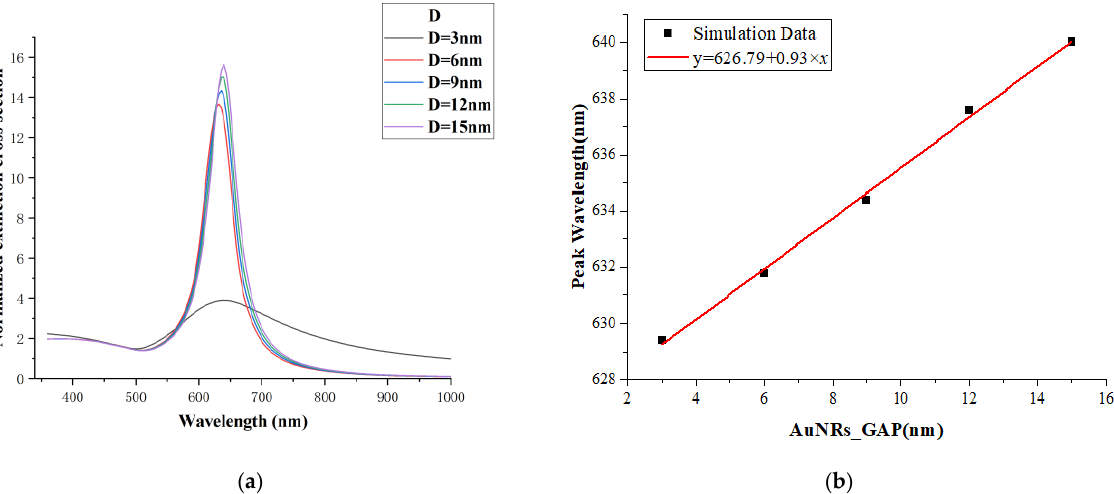
Figure 4. ( a ) The extinction cross-section of the gold nanorod dimer in the juxtaposed structure; ( b ) the relationship between the arrangement spacing of the gold nanorod dimer and the resonance peak wavelength.